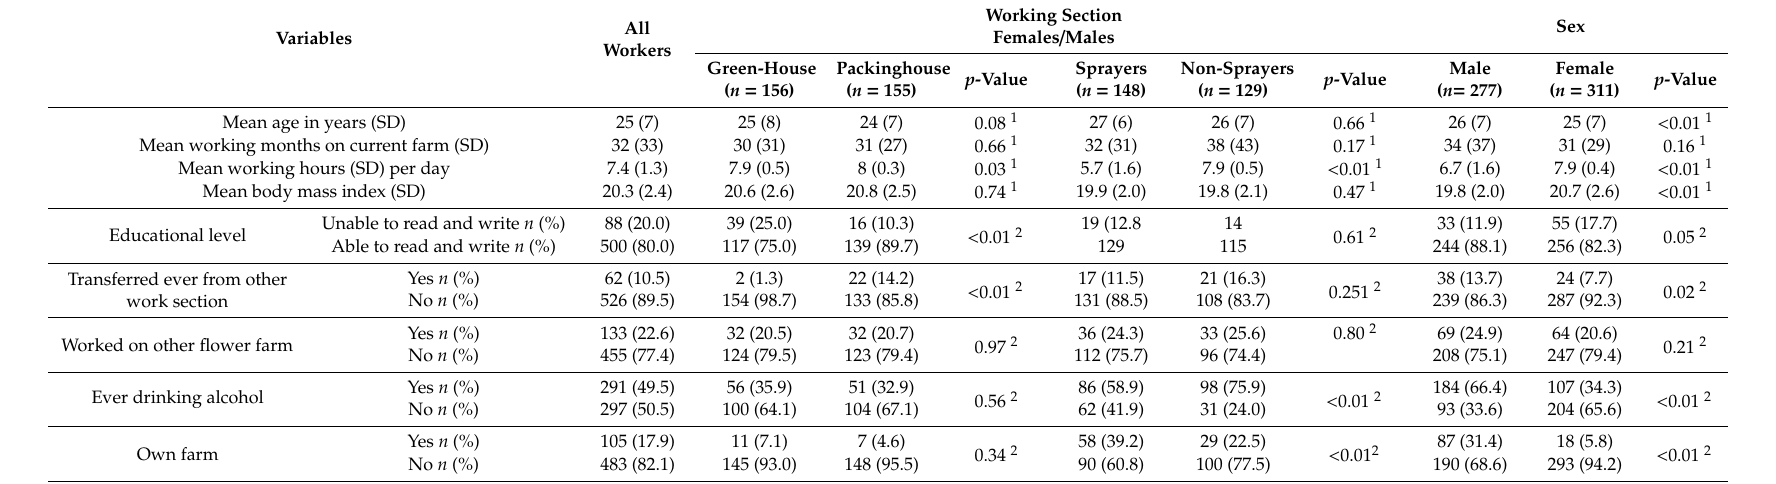
Table 2. Characteristics of participating flower farm workers in a study of pesticide exposure in Ethiopia, 2017.